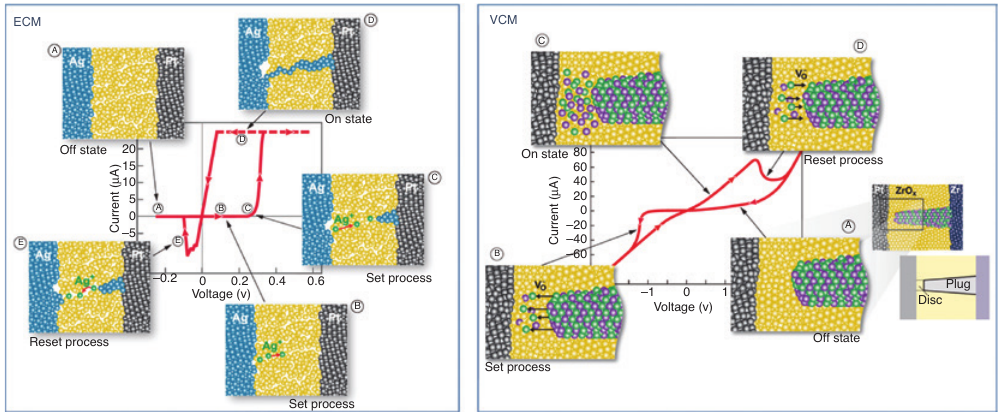
Figure 1: Typical current-voltage characteristic of an Ag/Ag-Ge-Se/Pt electrochemical metallization (ECM) and Pt/ZrOx/Zr valence change memory (VCM)